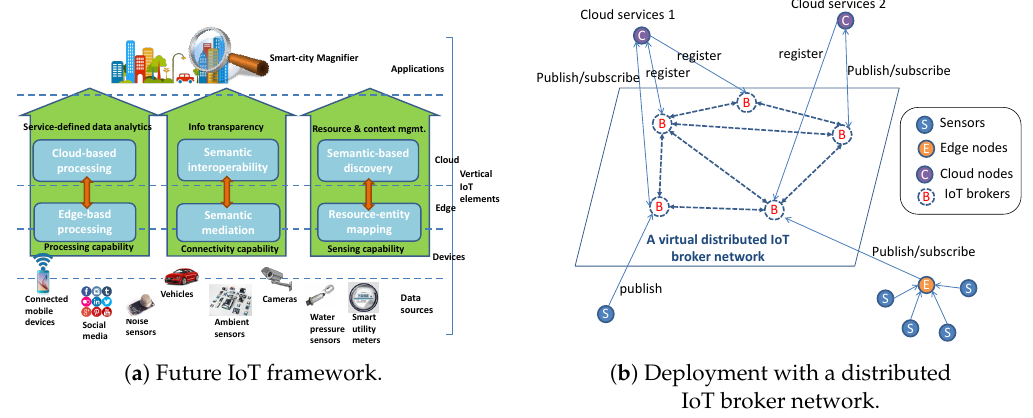
Figure 2. Future Hyper-connected